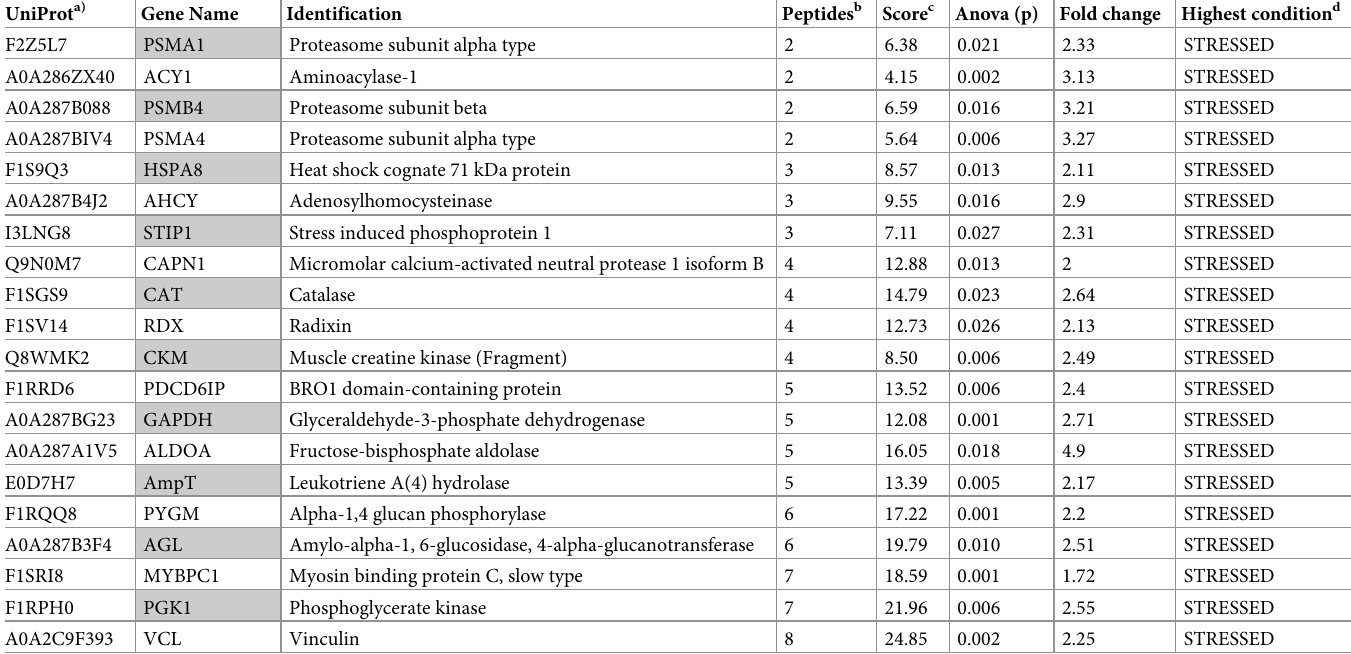
proteins up-regulated in the non-stressed pigs revealed a connected protein network com- posed by one big module composed by 32 nodes (Fig 2) divided in: one big module composed by 26 nodes (81.25%), a small component of two proteins (6.25%) and 4 singletons (12.5%). The resulting network showed a protein-protein interaction enrichment p-value of < 1.0e-16